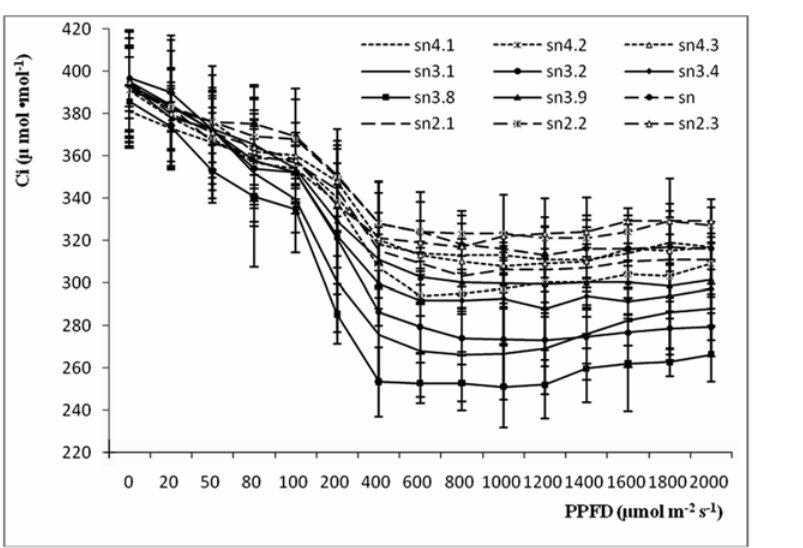
Fig 4. Ci-Par curves of poplar clones of different ploidies.